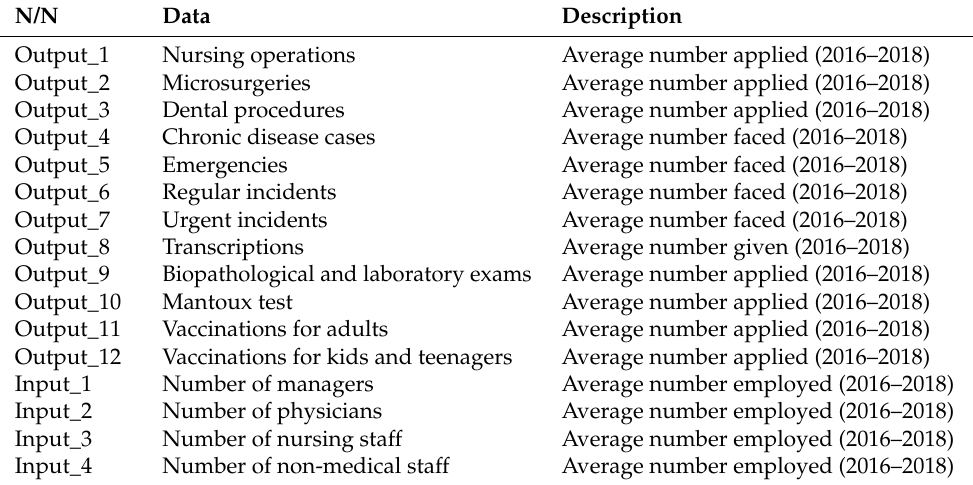
Table 1. Data used for the DEA analysis.